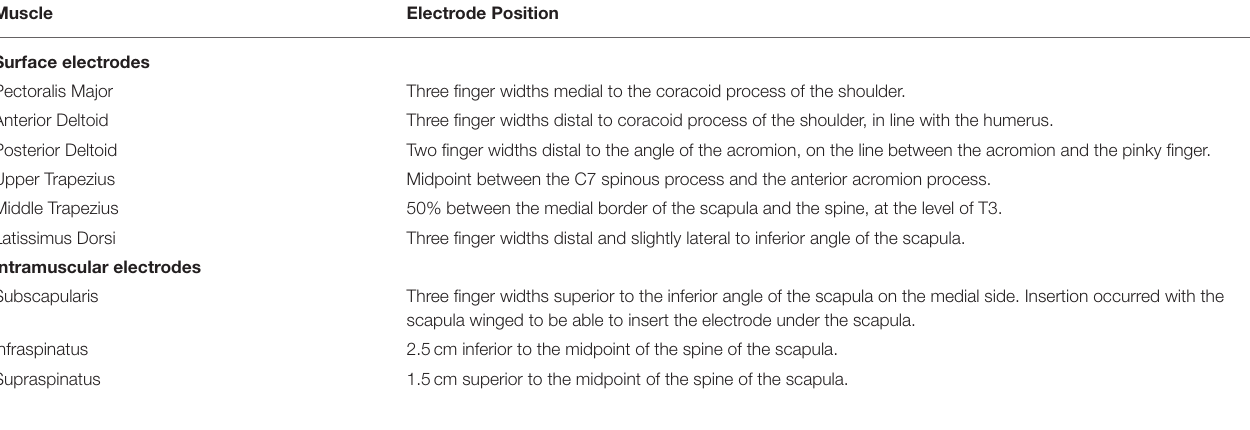
TABLE 2 | EMG electrode placements. Muscle